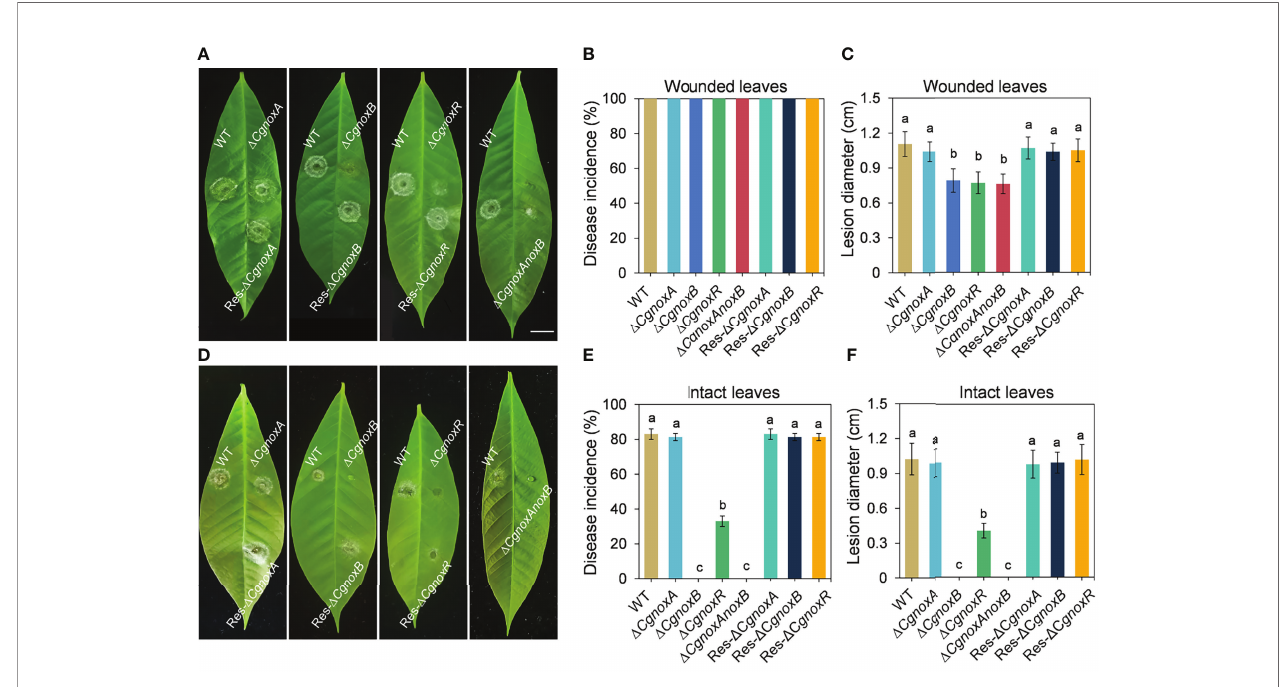
FIGURE 2 | Pathogenicity assay of WT, D CgnoxA , D CgnoxB , D CgnoxR , D CgnoxAnoxB , Res- D CgnoxA , Res- D CgnoxB , and Res- D CgnoxR strains on rubber tree leaves. (A) Disease symptoms of pre-wounded rubber tree leaves at 4 day postinoculation (dpi). Scale bar = 1 cm. (B) Disease incidence of WT and mutant strains on pre-wounded leaves after 4 dpi. Values represent mean ± SD. (C) Mean lesion diameters on pre-wounded leaves after 4 dpi. Values represent mean ± SD. (D) Disease symptoms of intact rubber tree leaves at 4 day postinoculation (dpi). (E) Disease incidence of WT and mutant strains on intact leaves after 4 dpi. Values represent mean ± SD. (F) Mean lesion diameters on intact leaves after 4 dpi. Values represent mean ± SD. Columns with different letters indicate signi fi cant difference (p <